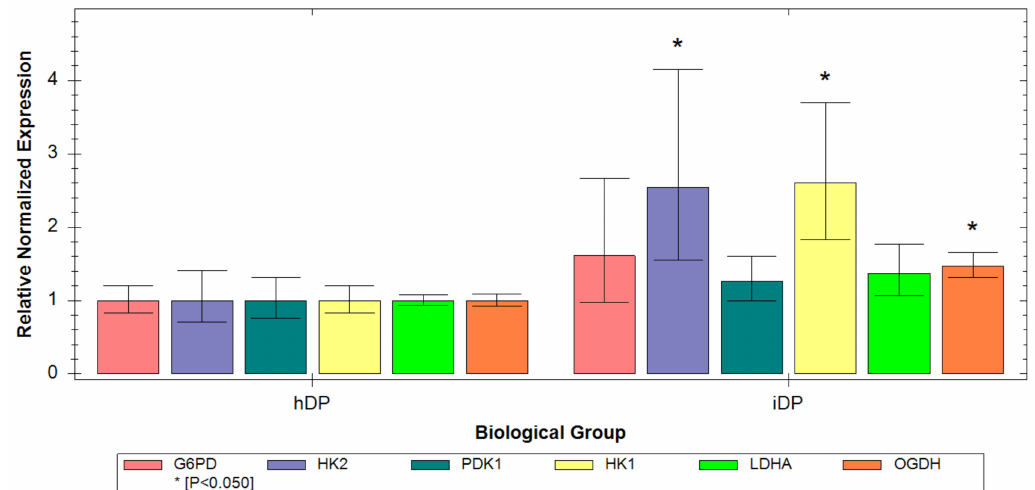
Figure 8. Expression of metabolic markers in the dermal spheroids. Quantitative PCR analysis: G6PD, HK2, PDK1, HK1, LDHA, and OGDH. Data were obtained using 3–4 independent biological replicates and are presented as mean ± SD.